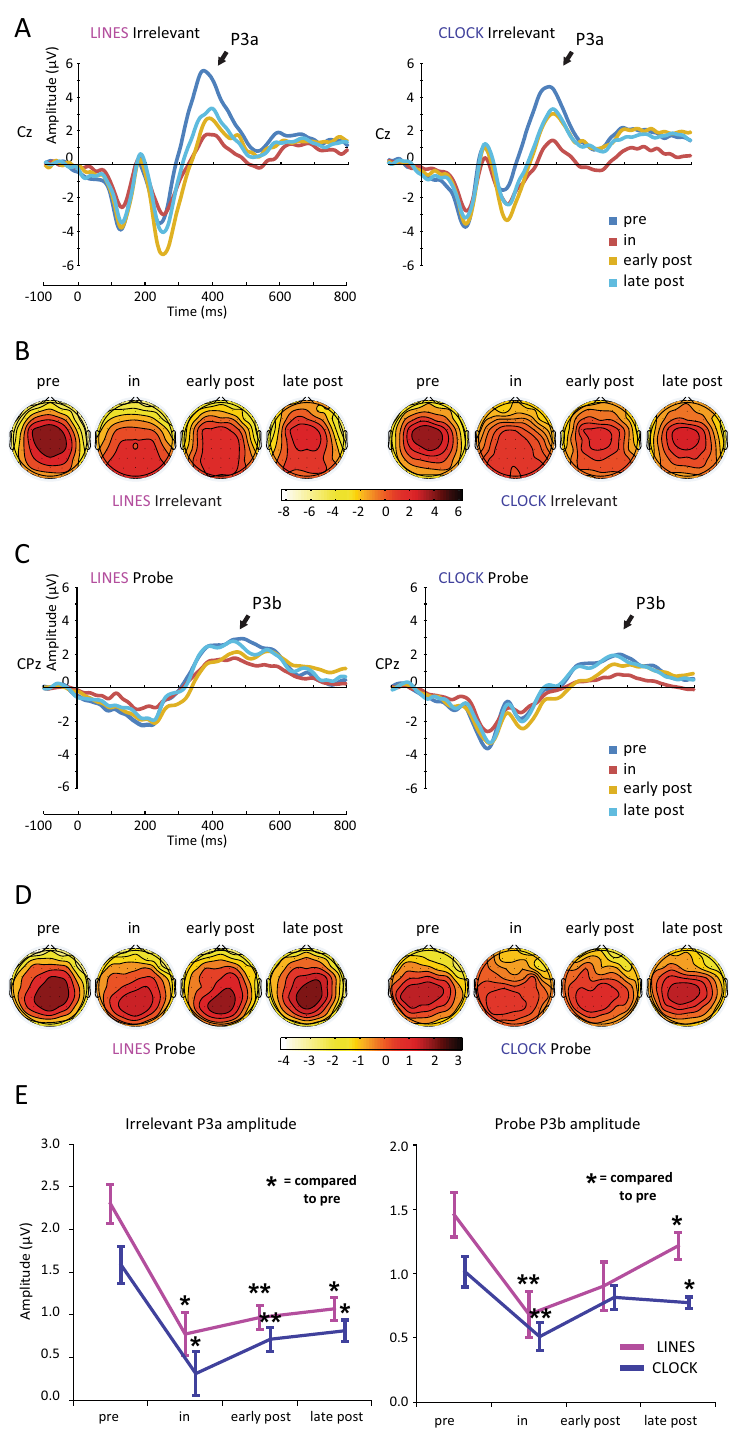
Figure 3. Event-related potentials in the Lines and the Clock task. ( A ) Grand mean ERP elicited by Irrelevant stimuli, presented on the Cz electrode. ( B ) Scalp distribution of P3a component, measured at peak latency (384.8 ms in both tasks). ( C ) Grand mean ERP elicited by Probe stimuli, presented on the CPz electrode. ( D ) Scalp distribution of P3b component, measured at peak latency (468.7 ms for the Lines, and 568.4 for the Clock task). ( E ) Amplitude of P3a and P3b elicited by Irrelevant and Probe stimuli, respectively, averaged over electrodes. P3a and P3b amplitudes showed similar spaceflight related alterations, as both components decreased significantly during in-flight compared to pre-flight. No differences were present between the two in-flight sessions. Compared to pre-flight, amplitudes remained decreased throughout the post-flight period. Error bars represent within-subjects SEM 22 . ** p < 0.01; * p <